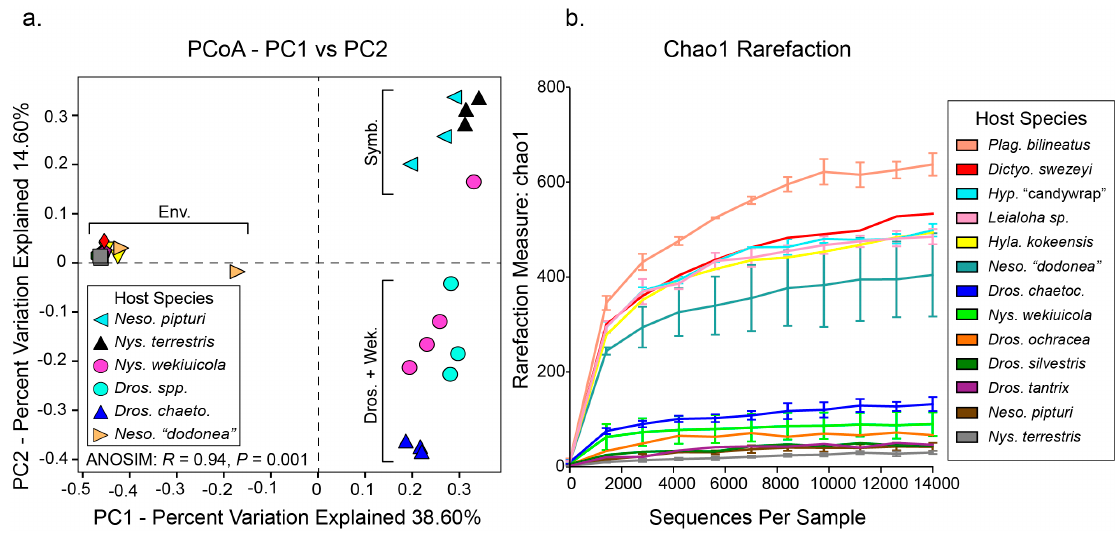
Figure 1. ( a ) PCoA of bacterial communities by insect sample based on unweighted unifrac distances. Samples that are stacked or tightly clustered are omitted from the inset legend. Clusters used in the ANOSIM analyses are labeled with brackets (Env. = Environmental, Symb. = intracellular symbiont associated, Dros. + Wek. = Drosophila spp. Nysius wekiuicola ). ( b ) Rarefaction curves with Chao1 diversity indices, indicating insect microbiome sampling depth and saturation in this study. Legend illustrates host insect species identity.